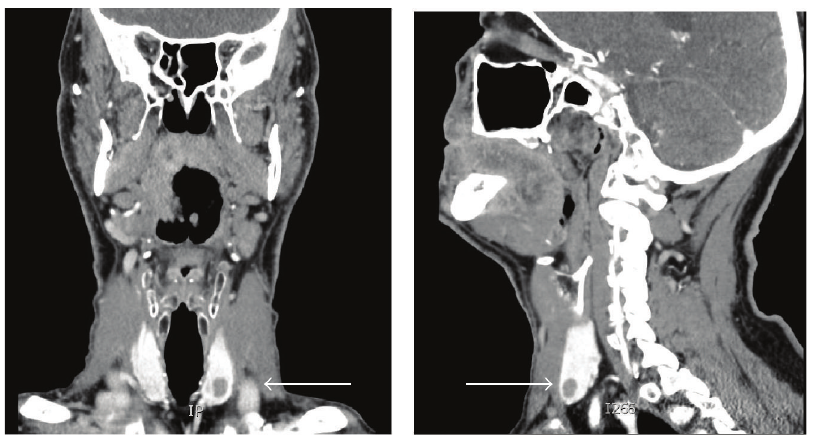
Figure 1: CT neck image of thyroid nodules (identified by white arrows).